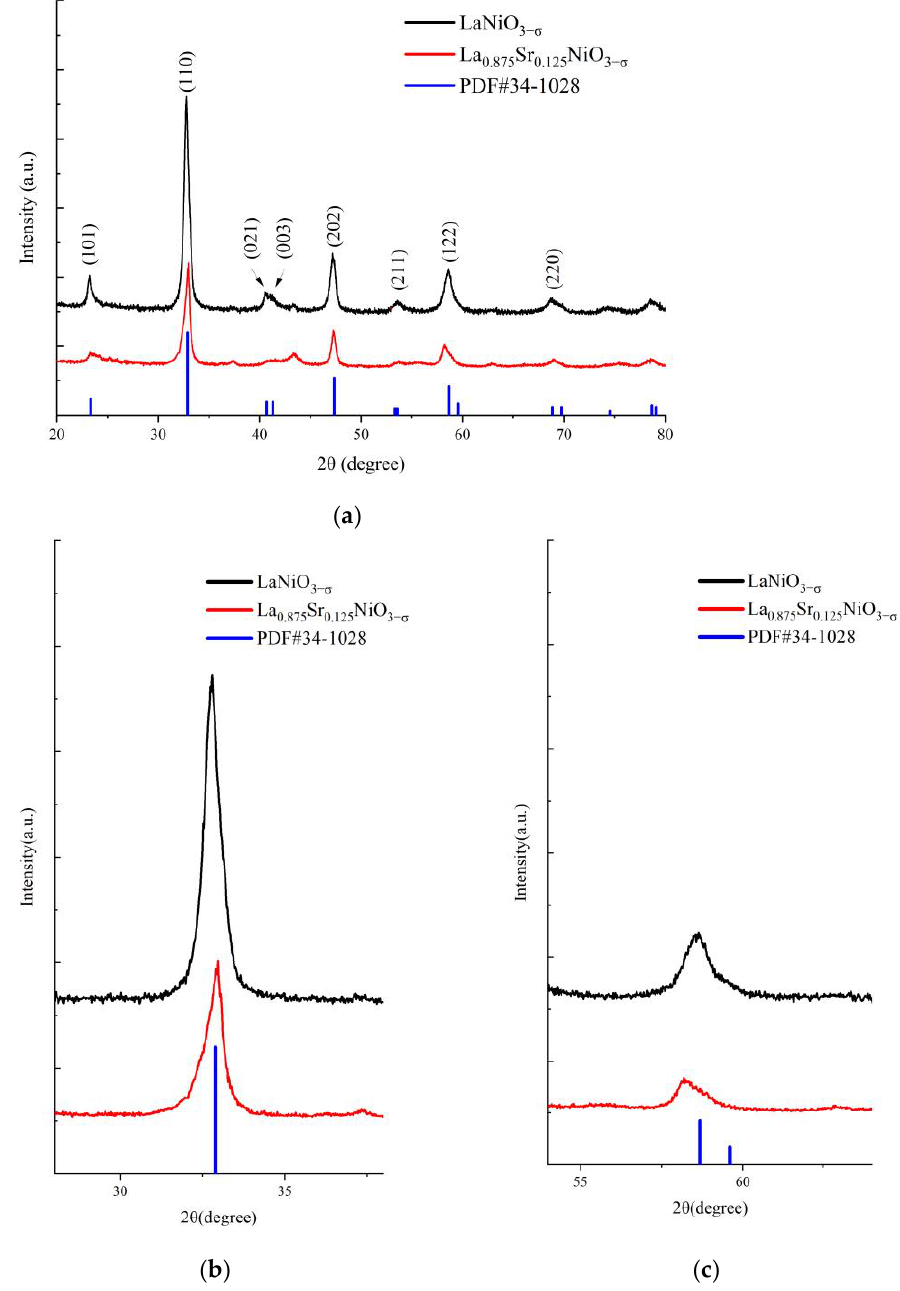
Figure 3. XRD spectrum of undoped and Sr-doped LaNiO 3−σ . ( a ) Full spectrum; ( b ) range 28° – 38°; ( c ) range 54° – 64°.